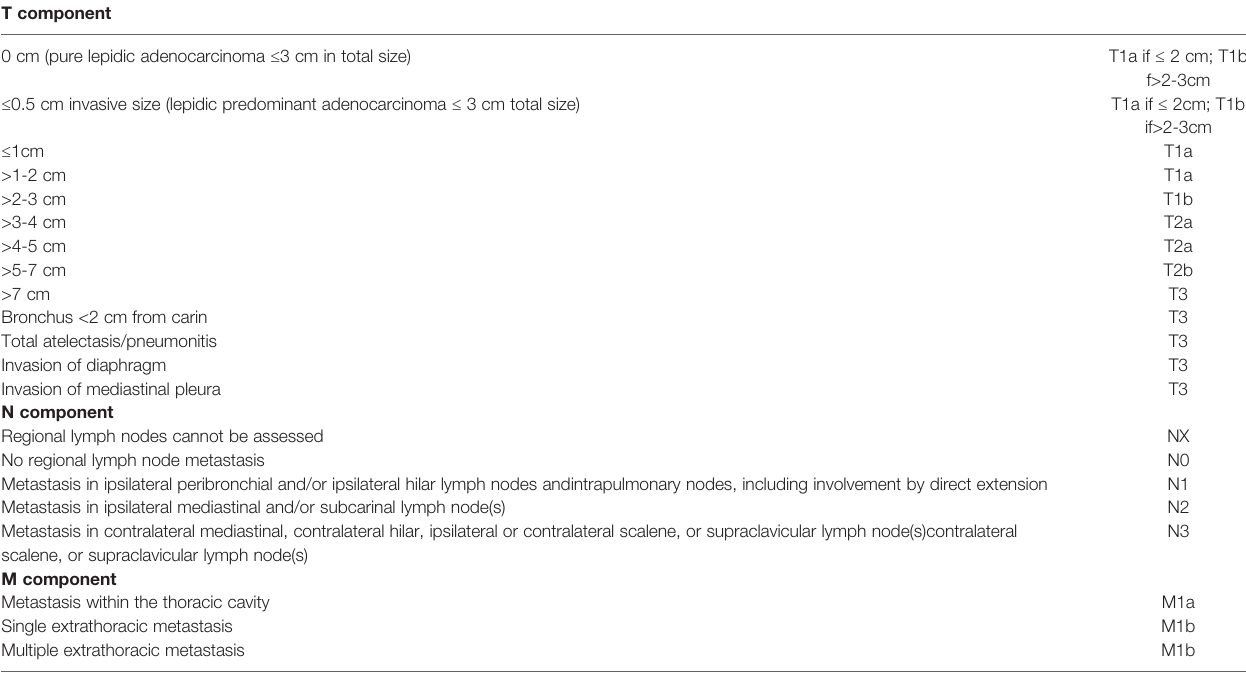
TABLE 6 | 7th Edition AJCC Cancer Staging Manual for NSCLC. T component 0 cm (pure lepidic adenocarcinoma ≤ 3 cm in total